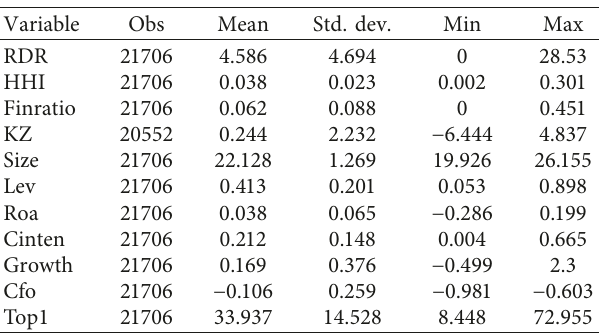
Table 2: Descriptive